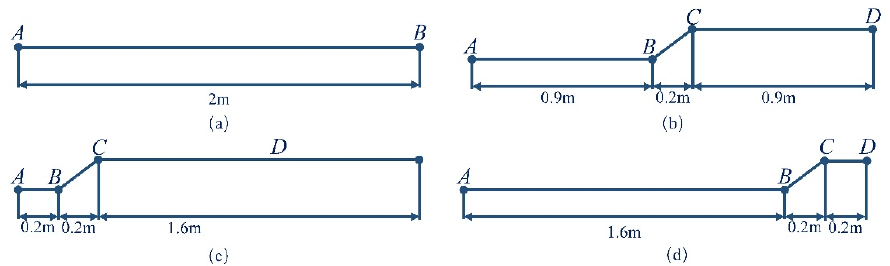
Figure 6. Motion path of the shearer: ( a ) straight motion path; ( b ) bending motion path with the bend in the middle of the path; ( c ) bending motion path with the bend in the end of the path; ( d ) bending motion path with the bend in the other end of the